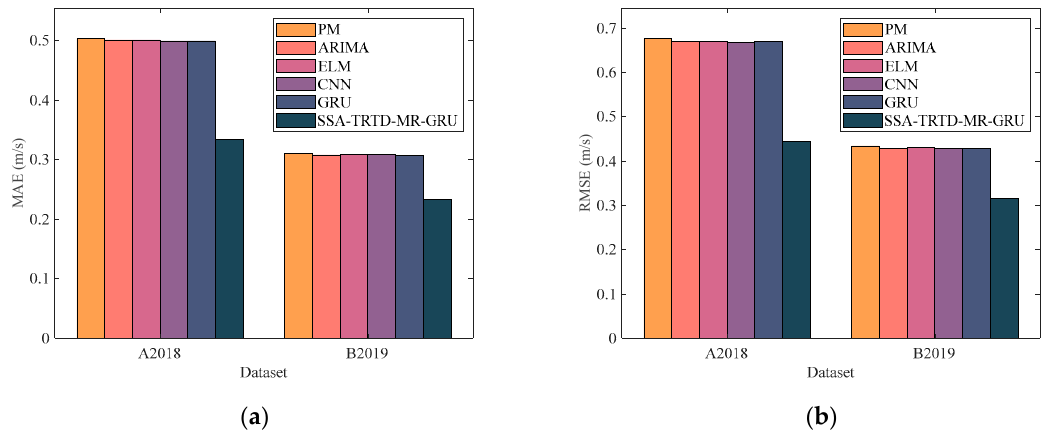
Figure 10. The comparison between the models without data composition and the proposed model: ( a ) MAE; ( b ) RMSE.